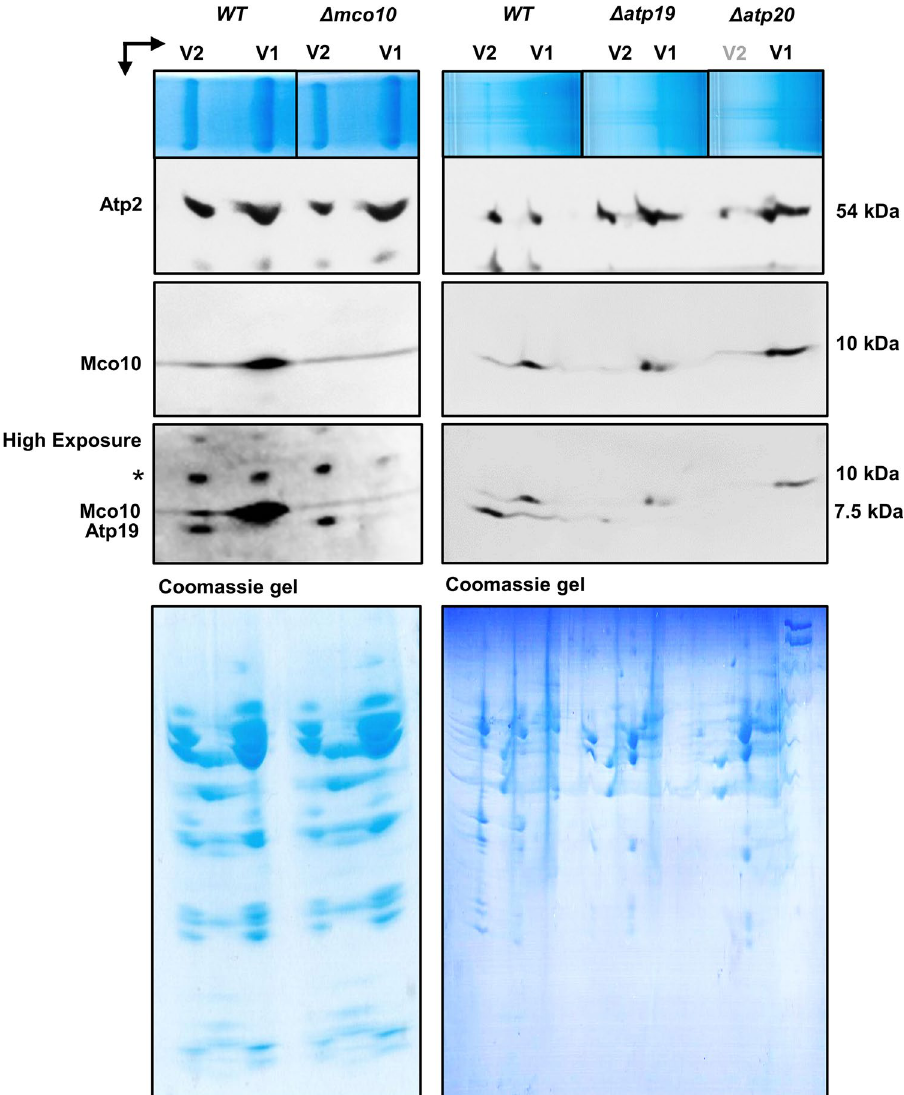
Figure 6. Mco10 is mainly present in the monomer of ATP synthase. The two-dimensional BN-SDS-PAGE gel separation of monomer and dimer subunits. After migration proteins were transferred to PVDF membrane and visualized by western blotting with respective antibodies. The upper panel shows the separation of the monomers and dimers in the first dimensional native gel. The lower panel shows the Coomassie stained second dimensional denaturing gels. Star indicates the nonspecific protein strongly recognized by anti-Atp19 antibody. Original blots/gels are presented in SupplementaryRowImages page 8. The representative gels are